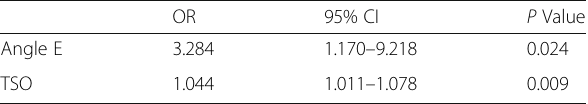
Table 3 Multivariate Logistic regression results of KSS improvement